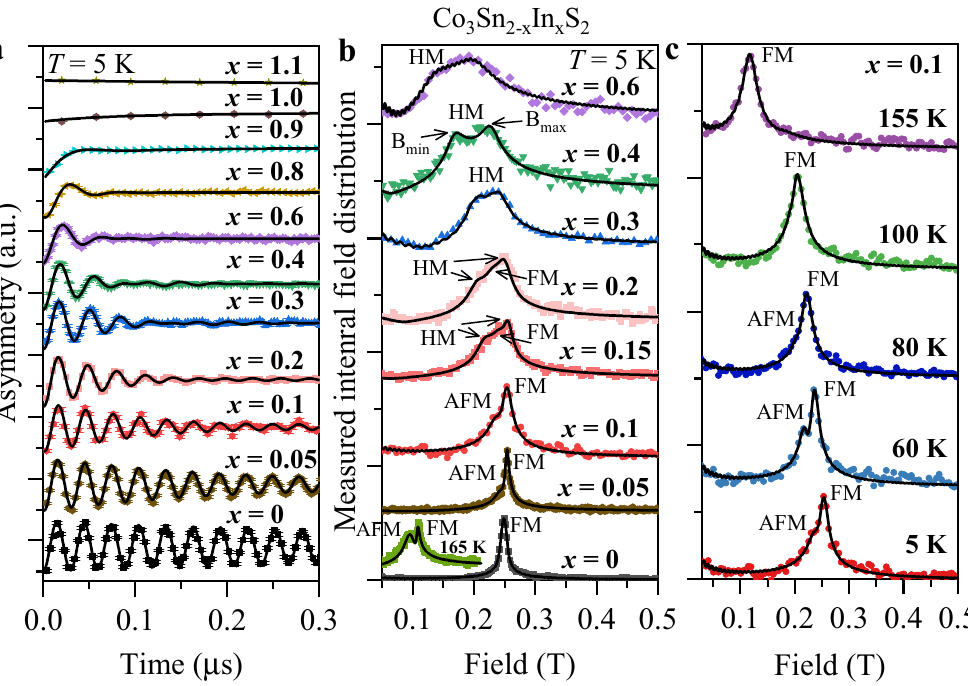
Fig. 2 (Color online) Zero- fi eld (ZF) μ SR time spectra for CoSn 2 − x In x S 2 . Zero- fi eld (ZF) μ SR time spectra ( a ) and the corresponding Fourier transform amplitudes ( b ) of the oscillating components for undoped and various In-doped CoSn 2 − x In x S 2 , recorded at 5 K. FFT amplitude for the x = 0 sample, recorded at 165 K, is also shown. The error bars represent the s.d. of the fi t parameters. c Fourier transform amplitudes of the oscillating components of the μ SR time spectra for various temperatures for the x = 0.1 sample. FFT amplitudes were normalized to its maximum value to make the signals well visible especially for samples for high In-doping. FM, AFM, and HM denote the out-of-plane ferromagnetic, in-plane antiferromagnetic and helical orders, respectively (see the text for the